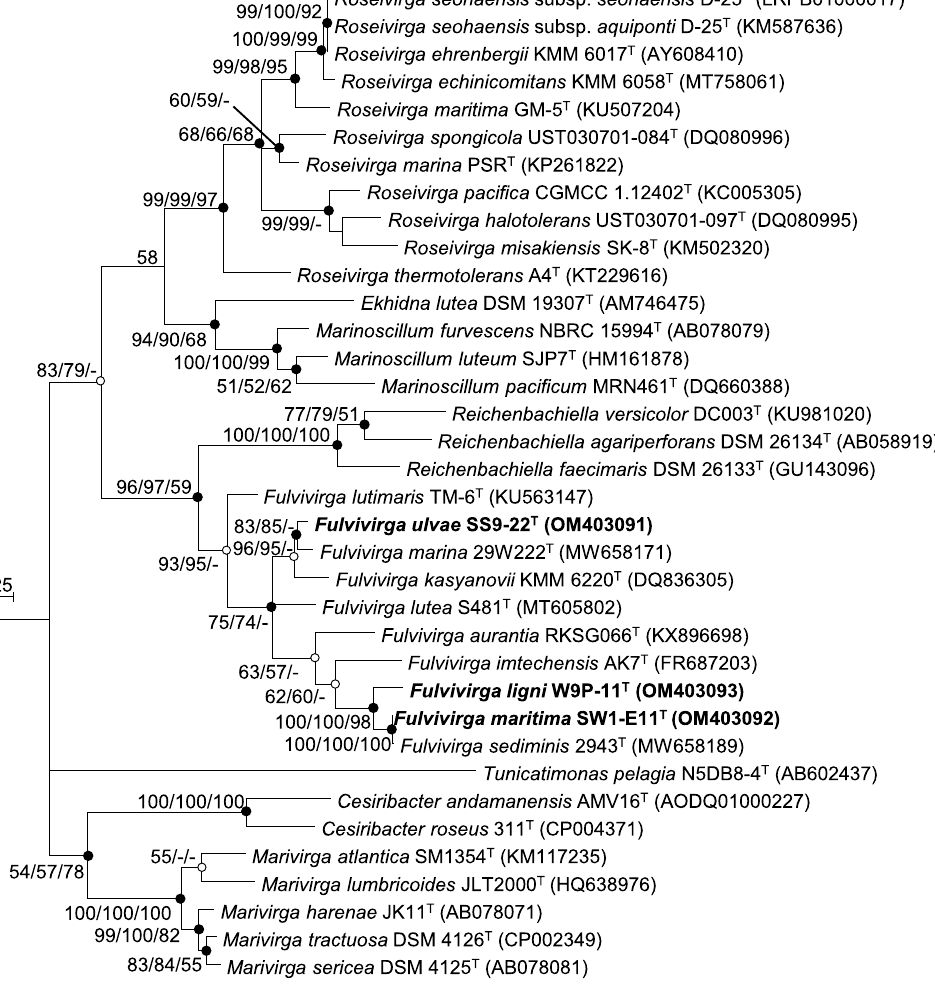
Figure 2. Maximum-likelihood phylogenetic tree constructed by MEGA7 software (version 7.0.26) based on 16S rRNA sequences showing the positions of three novel strains SS9-22 T , W9P-11 T , and SW1-E11 T with their closest representatives belonging to the order Cytophagales. Strain Flavobacterium aquatile NBRC 15052 T (GenBank accession number AB517711) was used as the outgroup. GenBank accession numbers are shown in parentheses. The 16S rRNA sequences were aligned by ClustalW and the result was trimmed in BioEdit software (version 7.2.5). The bootstrap resampling method of 1000 replicates was applied to evaluate the phylogenetic tree. Bootstrap values > 50% are presented. The closed circles stand for consensus of recovered nodes by using three algorithms, ML, NJ, and MP, respectively. The open circles stand for consensus of recovered nodes found from two out of three algorithms. Bar, 0.025 substitutions per nucleotide